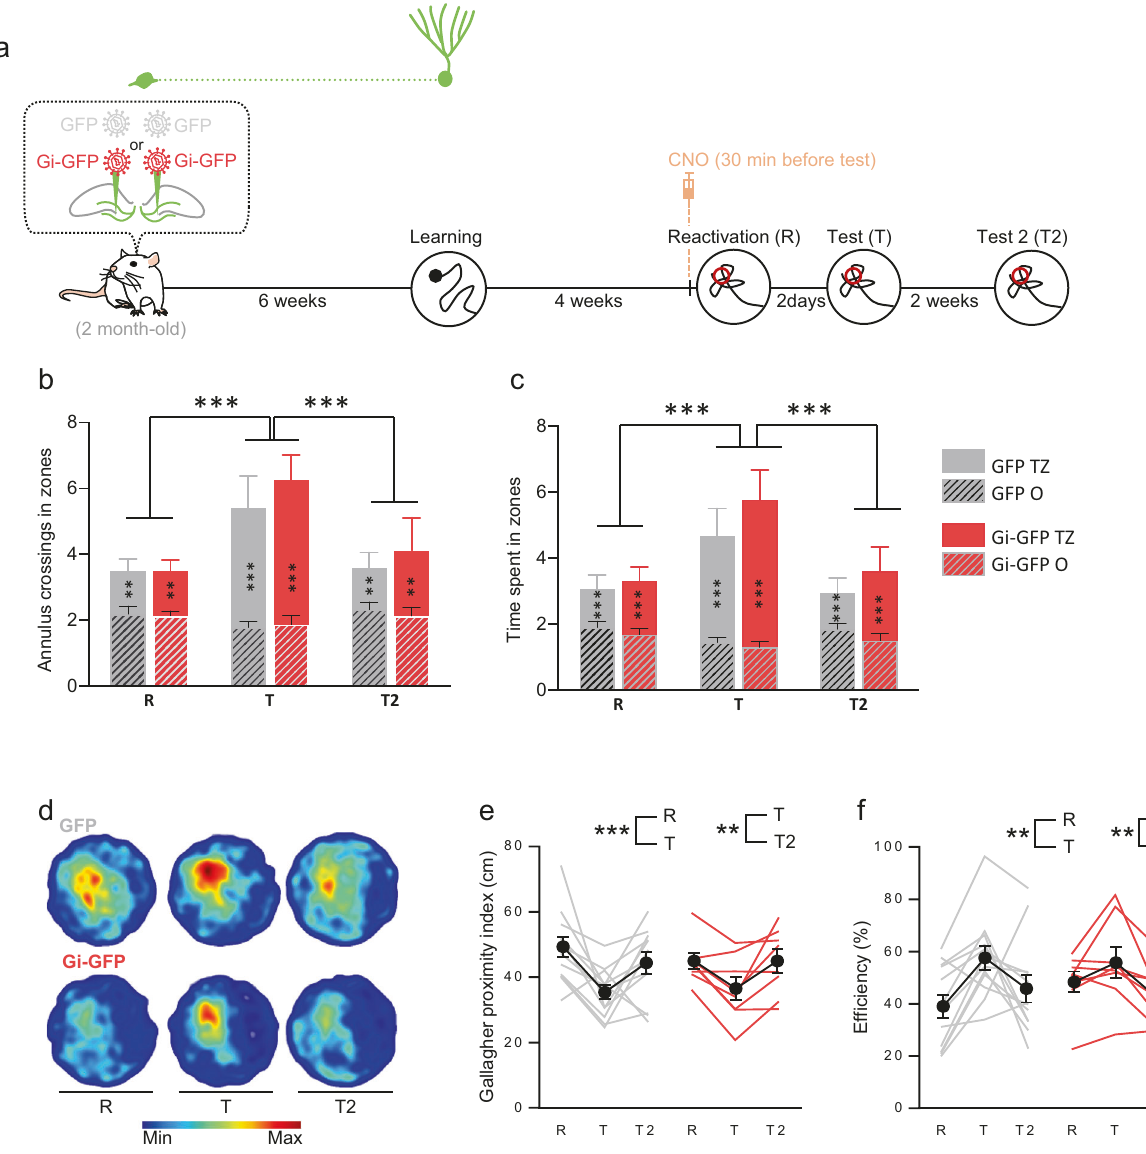
Fig. 7 Silencing during reconsolidation, neurons that were 6-week old at the time of learning, has no impact on memory updating. a Experimental protocol: 2-month-old rats were injected with Gi-GFP RV ( n = 12) or its control GFP RV ( n = 11) 6 weeks before MWM training. Rats were trained for 6 days and memory was reactivated 4 weeks later. Thirty minutes before reactivation, rats were injected (i.p.) with 1 mg/kg CNO. Memory was tested 2 days later (Test) and again 2 weeks later (Test 2). At the end of each reactivation and test sessions, the Atlantis platform (indicated by ○ ) raised and rats were put on the platform for 30 s. b , c Cross entries and time spent in the MWM zones (T: Target zone; O: others zones). The reactivation with the Atlantis platform led to an increase in the number of entries and the time spent in the target zone at the test for both GFP control rats and Gi-GFP rats (Tukey ’ s test: ** p < 0.01, *** p < 0.001). d Density plot for grouped data: The color level represents the lowest (Min) to the highest (Max) location frequency in pixels. e , f Gallagher Proximity and Ef fi ciency during reactivation and tests. The reactivation with the Atlantis platform led to an increase in Gallagher and Ef fi ciency performances at the test for both GFP control rats and Gi-GFP rats (Tukey ’ s test: ** p < 0.01, *** p < 0.001). All data shown are mean ± s.e.m. For statistical details, see Table